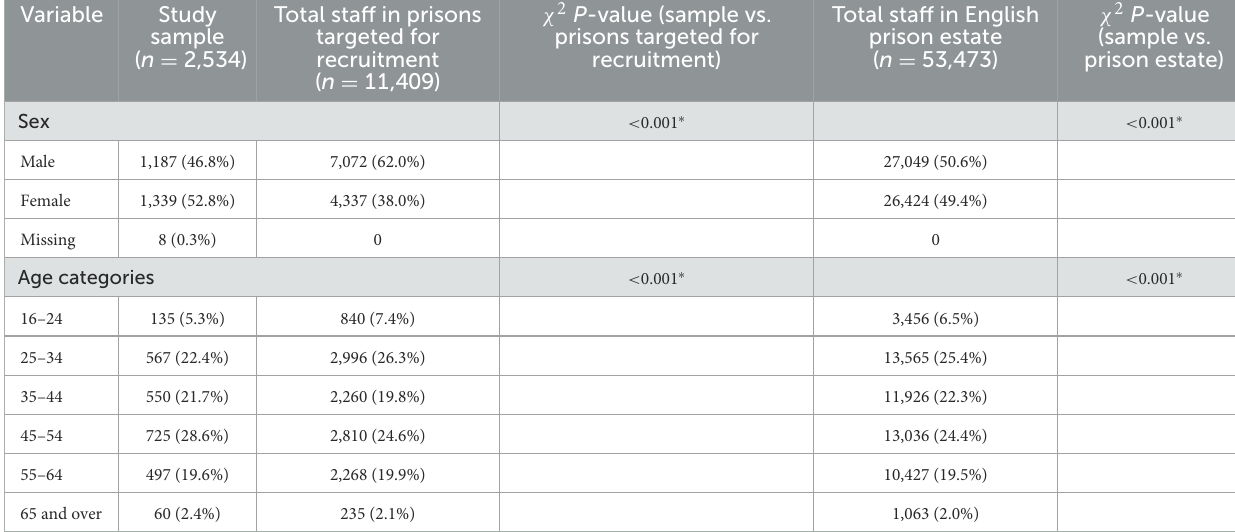
TABLE 1 Comparison of age and sex distributions between sample, total staff in prisons targeted for recruitment, and total staff in English prison estate.